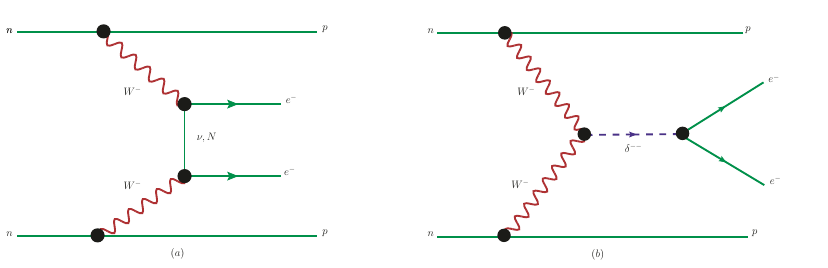
Figure 12. Feynman diagrams representing the neutrinoless double beta decay: 2 n (0 (cid:23) 2 (cid:12) ). The [ ] represents e(cid:11)ective vertex. 0 (cid:23) 2 (cid:12) can acquire additional contributions from (a) (cid:15) light and heavy Majorana neutrino exchange, and (b) from doubly charged scalars too.